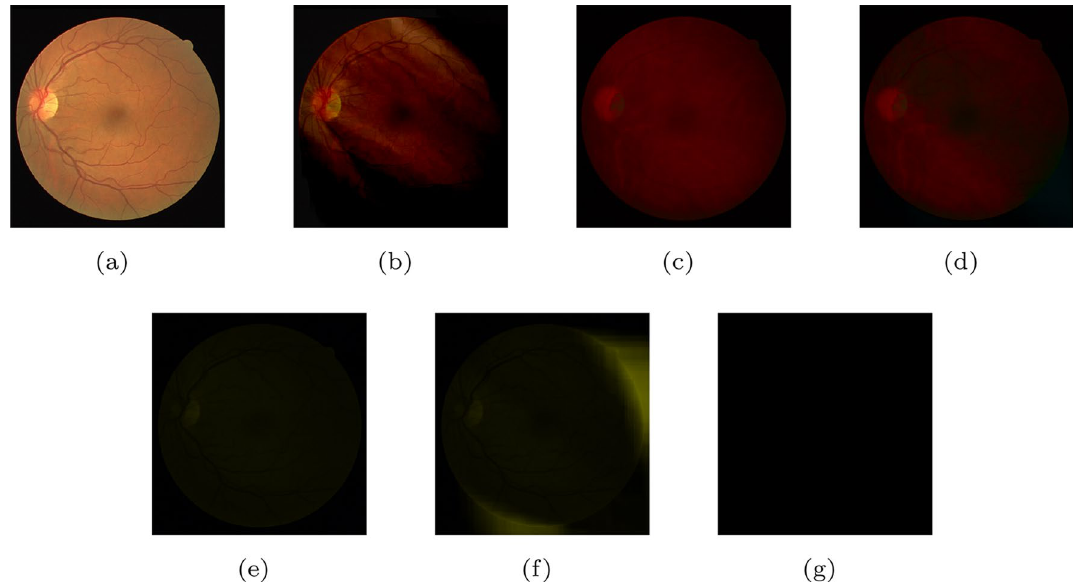
Figure 3. ( a ) The original image. ( b ) The reconstructed image without component Y S . ( c ) The reconstructed image without components Y S and Y D . ( d ) The reconstructed image without components Y S , Y D and U S . ( e ) The reconstructed image without components Y S , Y D , U S and U D . ( f ) The reconstructed image without components Y S , Y D , U S and U D . ( g ) The reconstructed image without components Y S , Y D , U S , U D , V S and V D . See the text for more